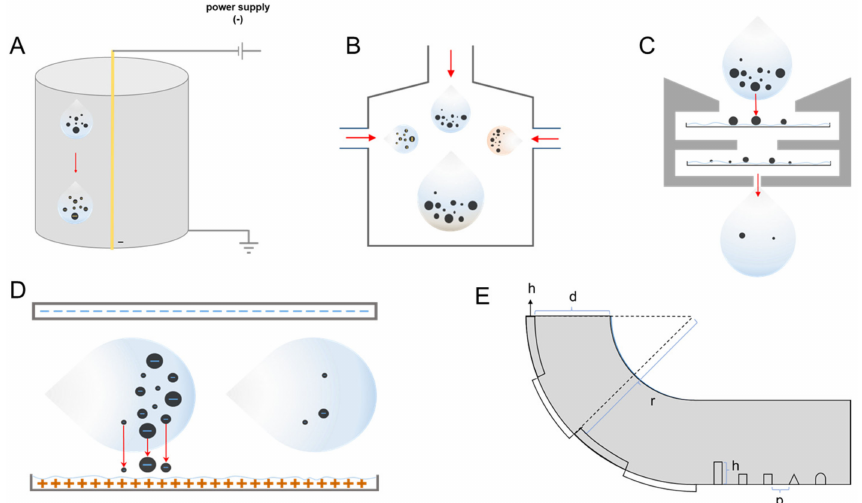
Figure 2. Schematic illustration of enhancement techniques for collection of airborne virus. ( A ) Precharge; ( B ) Premixing; ( C , D ) Liquefied collection plate; ( E ) Cavities and